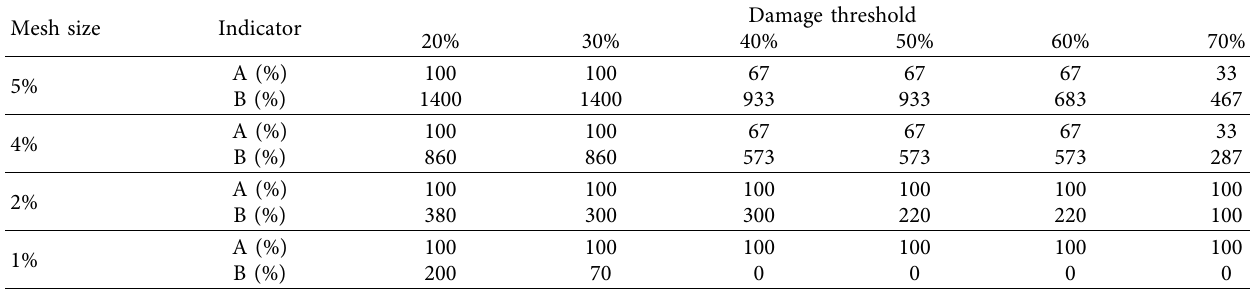
Table 9: Damage capacity indicators for the second preliminary damaged